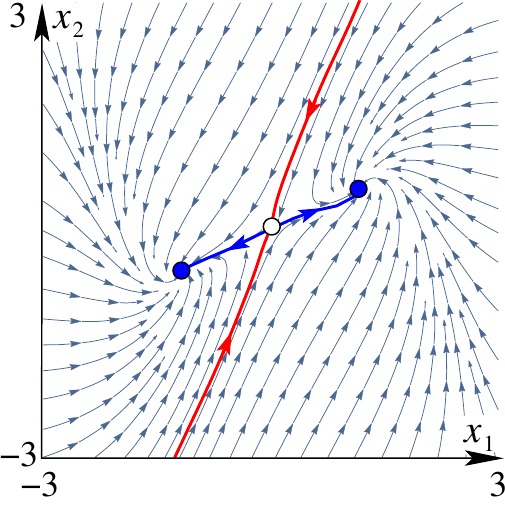
Figure 1. Velocity field of a sample dynamical system. For a two-dimensional dynamical system (3) modelling a neuron, several phase trajectories are shown (thin blue lines) being guided by the velocity vector field (arrows). The features of the velocity field include two stable fixed points (filled circles), the boundary between their basins of attraction (red line), which is a stable manifold of the saddle fixed point (empty circle), and the unstable manifold of the saddle point (thick blue